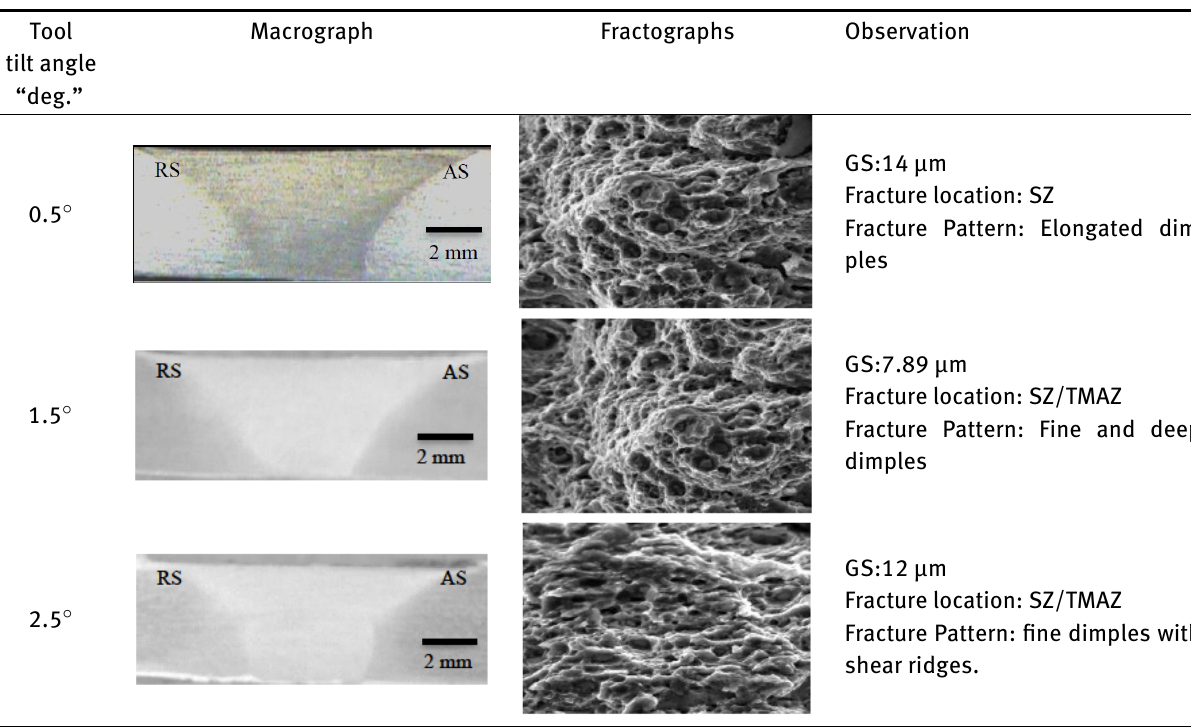
Table 8: Effect of tool tilt angle on macrograph and fracture pattern Tool tilt angle